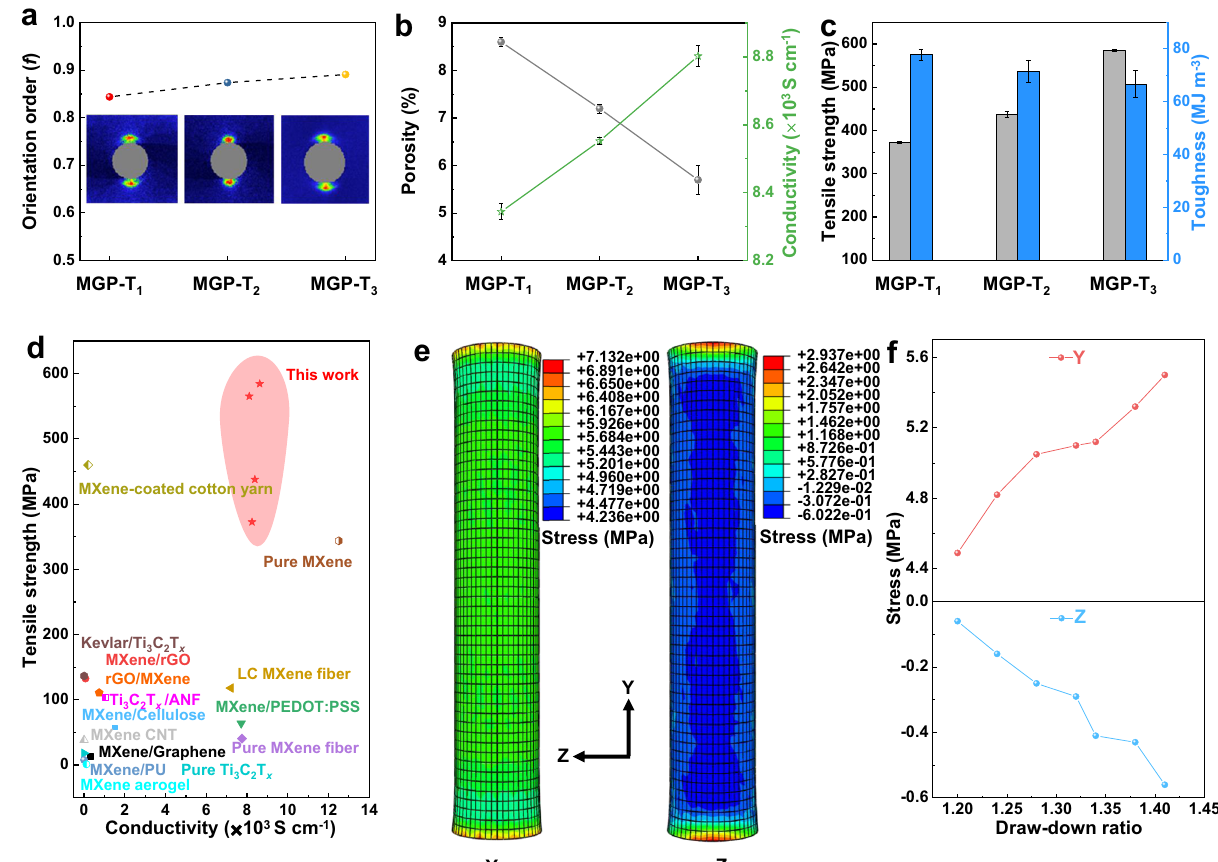
Fig. 4 | Mechanical properties and mechanism of MGP-T fi bers by thermal drawing. a Orientation order of MGP-T fi bers fabricated by various draw-down ratiosaccordingtotheWAXSpatterns.Curvesofthe porosityand conductivity( b ) and tensile strength and toughness ( c ) of MGP-T fi bers. d Comparison of tensile